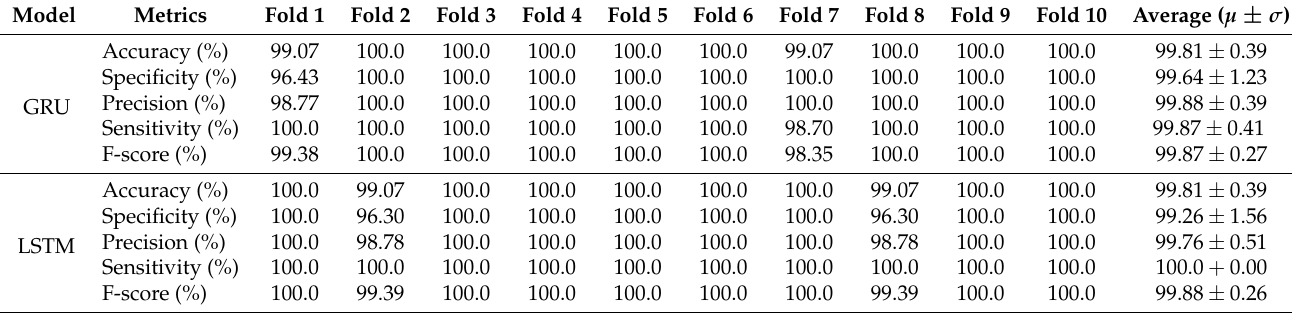
Table 6. The classification performance obtained using RNN classifiers with the 10-fold CV approach for the automated classification of the BMAC vs. GMAC